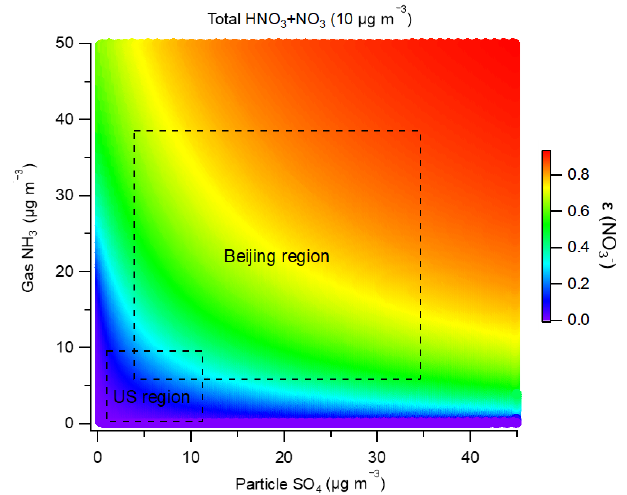
Figure 6. Sensitivity of the nitrate partitioning ratio / (HNO 3 + NO − ( ε (NO − ) = NO − )) to gas-phase ammonia and 3 3 3 PM 1 sulfate concentrations based on thermodynamic predictions under typical Beijing and Xinxiang summertime conditions. The total nitrate concentration is assumed to be 10µgm − 3 , according to the observed PM 1 nitrate